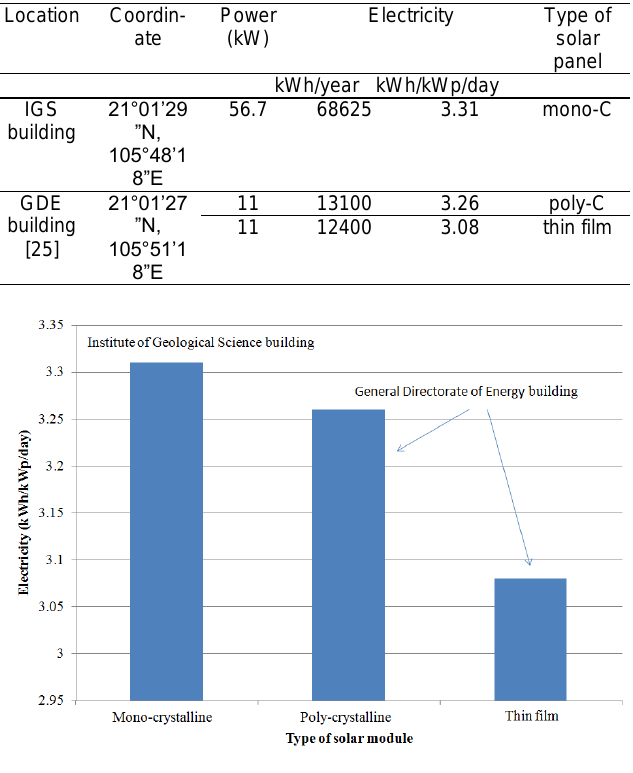
Figure 14. Comparative parameters of solar power stations in Hanoi